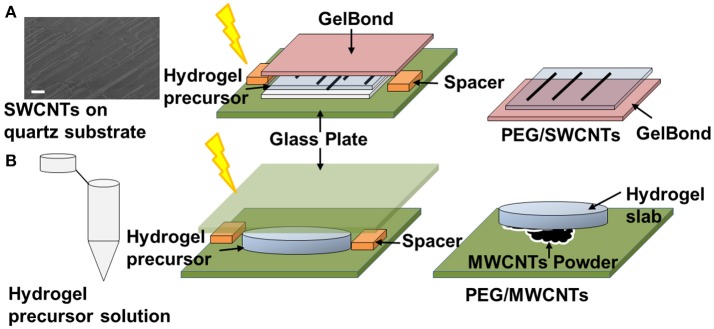
Schematic of CNT-hydrogel nanocomposites preparation. (A) Single-walled carbon nanotubes (SWCNTs) are grown on a quartz wafer in a first step. Representative SEM image shows the actual SWCNTs (scale bar is 10 μm). Then a hydrogel precursor solution is deposited on the quartz-grown SWCNTs, sandwiched with a GelBond flexible plastic support and exposed to 365 nm ultraviolet (UV) light (4.81 mW/cm2) for 10 min. Lastly, the GelBond/hydrogel construct is peeled off from the wafer with SWCNTS transferred onto the hydrogel. This nanocomposite is termed PEG/SWCNTs. (B) A hydrogel slab is made in a first step and then “stamped” onto dispersed multi-walled carbon nanotubes (MWCNTs) to form PEG/MWCNTs nanocomposites.